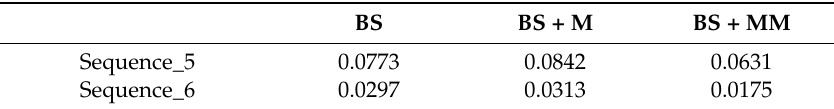
Table 19. Average F-m s of the evaluated BS algorithms test on Sequence_5 and Sequence_6.